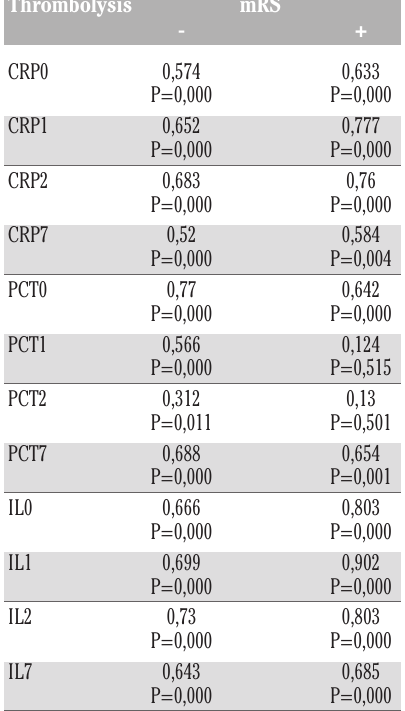
Table 4. Associations of neurological out- come three months after ischemic stroke measured using mRS and inflammatory markers (CRP, PCT and IL-10) in both groups. In both groups of patients signifi- cant positive associations for all inflamma- tory markers and neurological outcome was